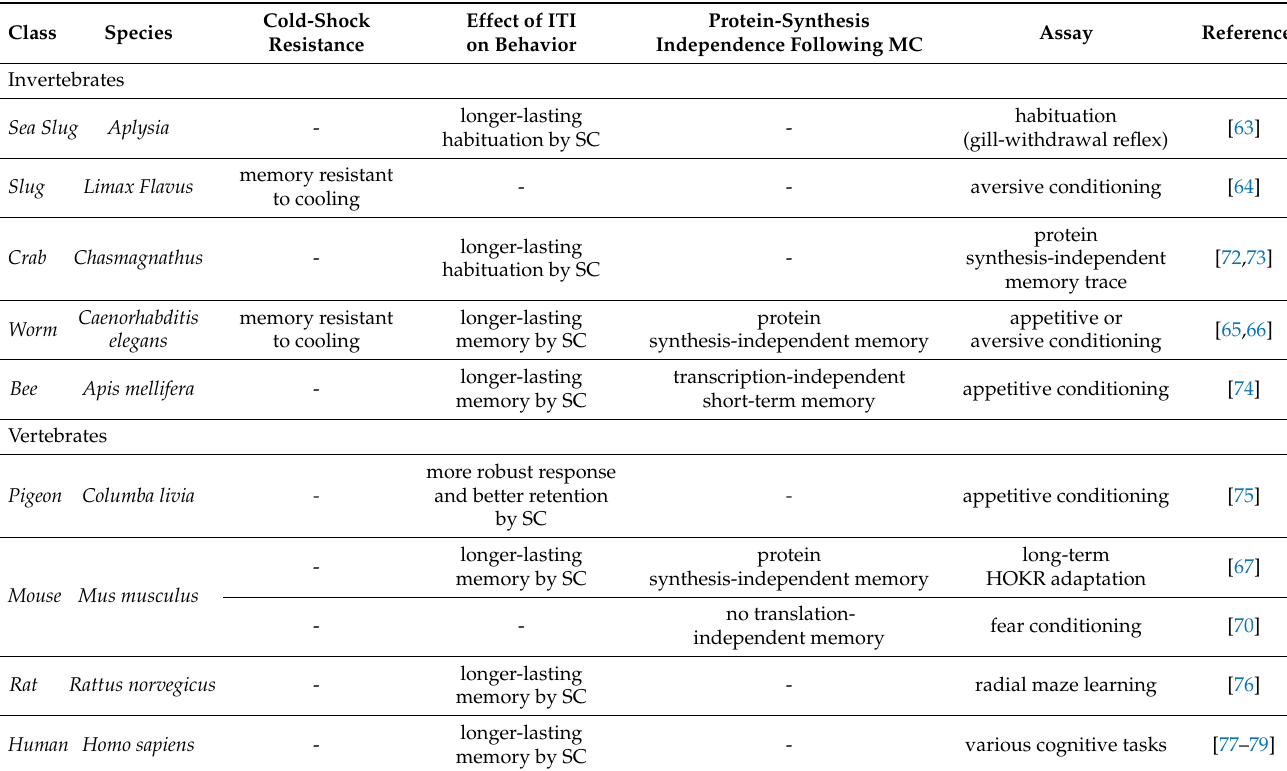
Table 4. Features that define ARM in Drosophila have been observed in other species. (ITI = Inter-trial